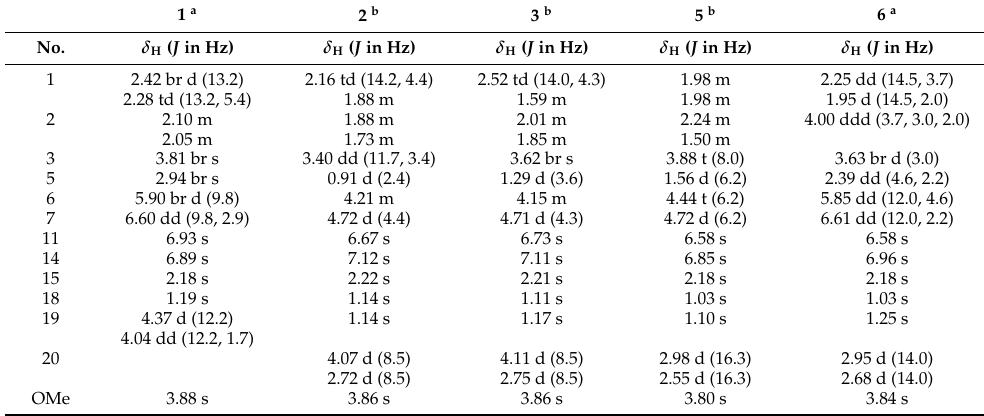
Table 1. 1 H NMR spectroscopic data of compounds 1 – 3 , 5 , and 6 .